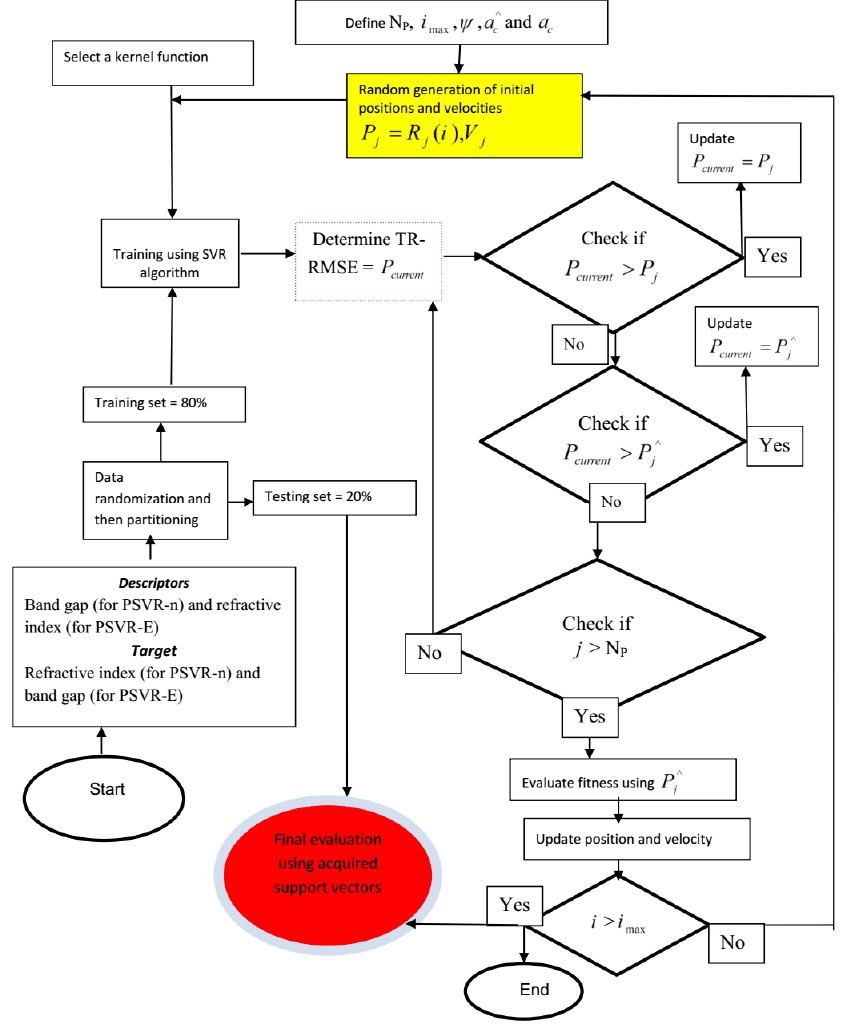
Figure 2. Computational architecture of the developed PSVR-based